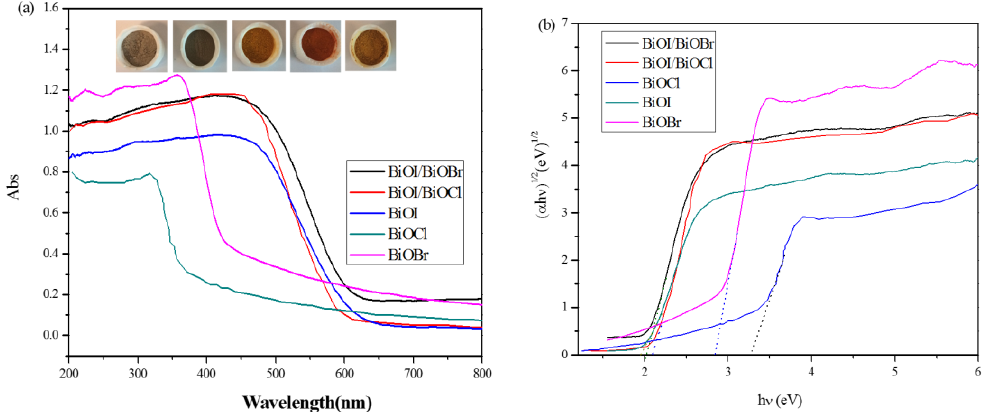
Figure 4. Ultraviolet-visible diffuse reflectance spectra (UV-Vis DRS) of ( a ) as-prepared samples and ( b ) the plotting of ( α h γ ) 1/2 vs. photon energy.